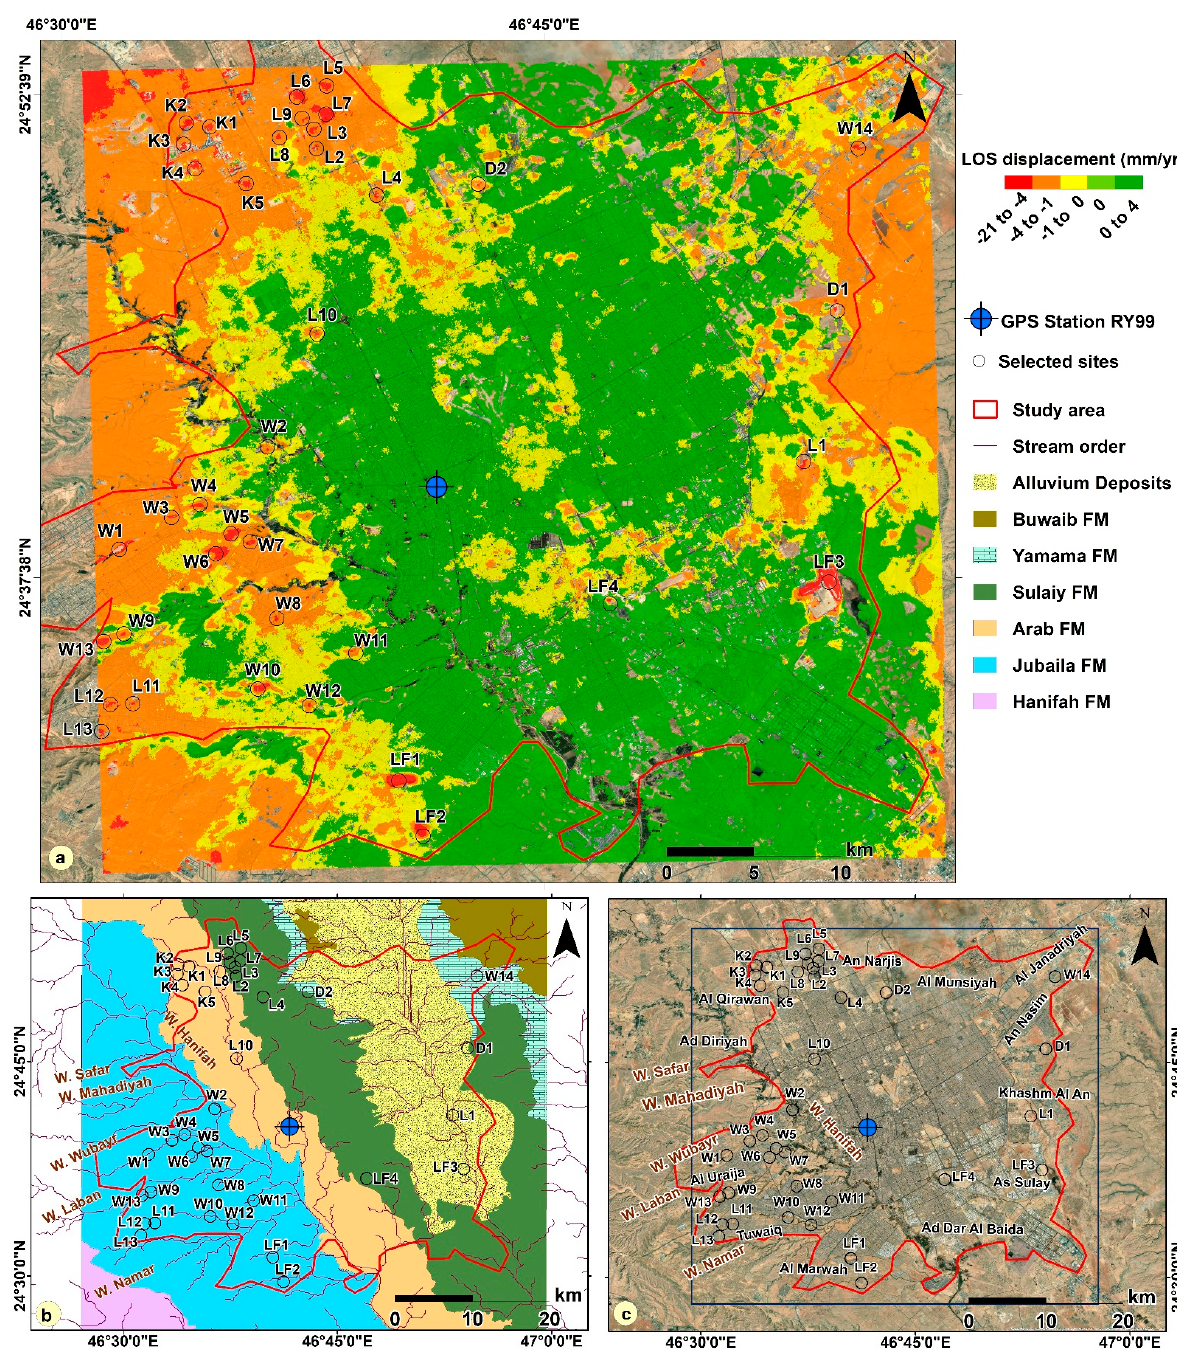
Figure 4. ( a ) Line of sight (LOS) land deformation (in mm/y) for the study area and surroundings extracted from the selected 30 Sentinel-1 ascending scenes (Table 1) that were acquired (2016–2018) over the study area and processed using synthetic aperture radar (SAR)scape. Negative velocities (orange to red) represent downward ground motion (subsidence), whereas positive (green) velocities represent stable or upward ground motion (uplift). ( b ) Distribution of wadis extracted from digital elevation map using an ALOS World 3D digital elevation model (DEM; resolution 30 m). ( c ) The distribution of districts within Riyadh. Further shown is the distribution of the 39 sites that show subsidence rates exceeding 4 mm/y, the location of the RY99 GPS station, and outline of the study area. Site locations preceded by the letter “L”, “W”, “K”, “LF”, and “D” indicate their occurrence over lowlands, wadis, karstic formations, landfills, and dumpsites,